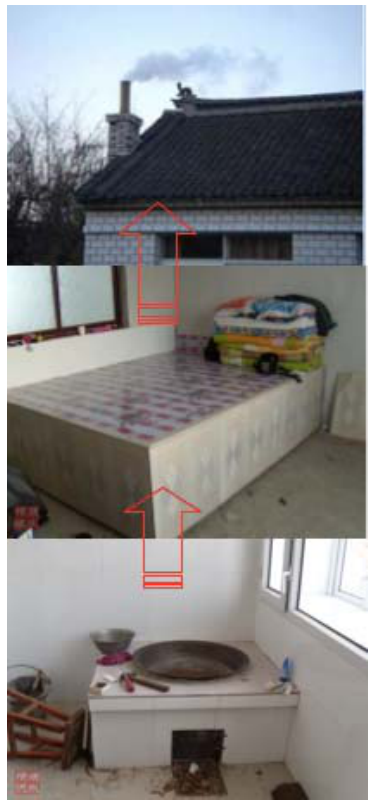
Figure 8. Stove, bed and chimney